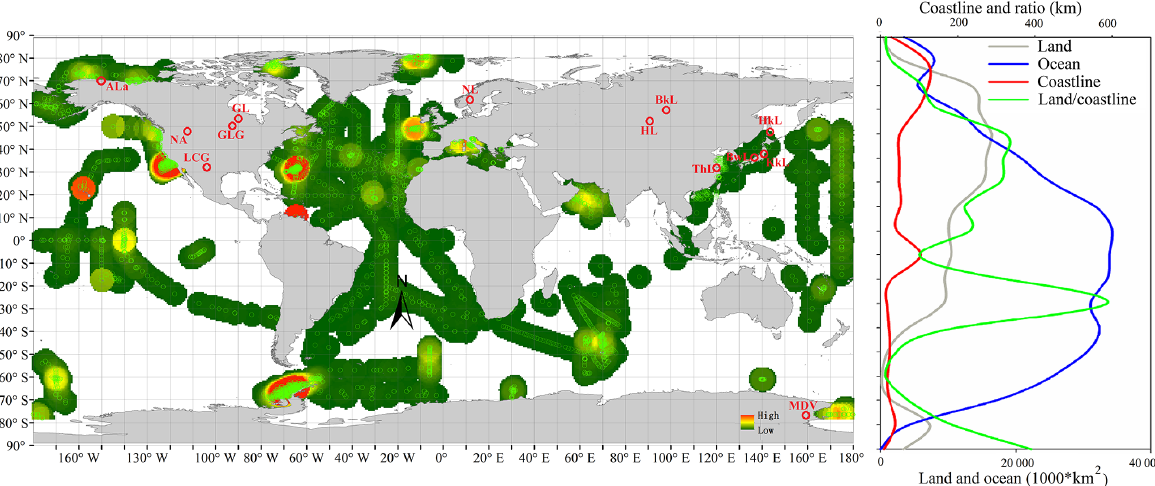
Figure 1. Global distribution of paired samples of POC and PON. Green circles are oceanic samples and red circles are inland samples. Land and ocean area, coastline length and the ratio of land area to coastline are also shown. The original map data of the world vector downloaded from